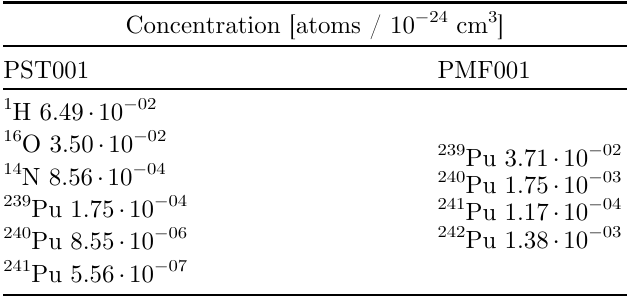
Table 1. Concentrations of the main isotopes in the two